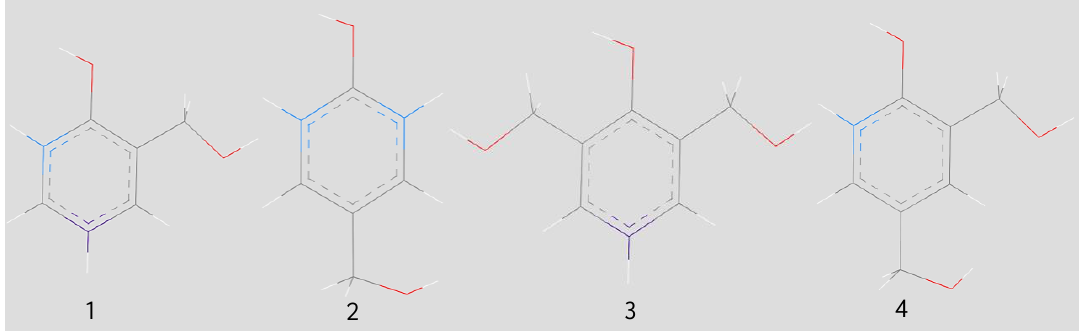
Figure 3. Mono-substituted (1 and 2) di-substituted (3 and 4) symthon structures used to populate unit cells to achieve different F:P ratios. Ortho (blue) and para (purple) sites are colored to give them a unique identifier for which the script can search.